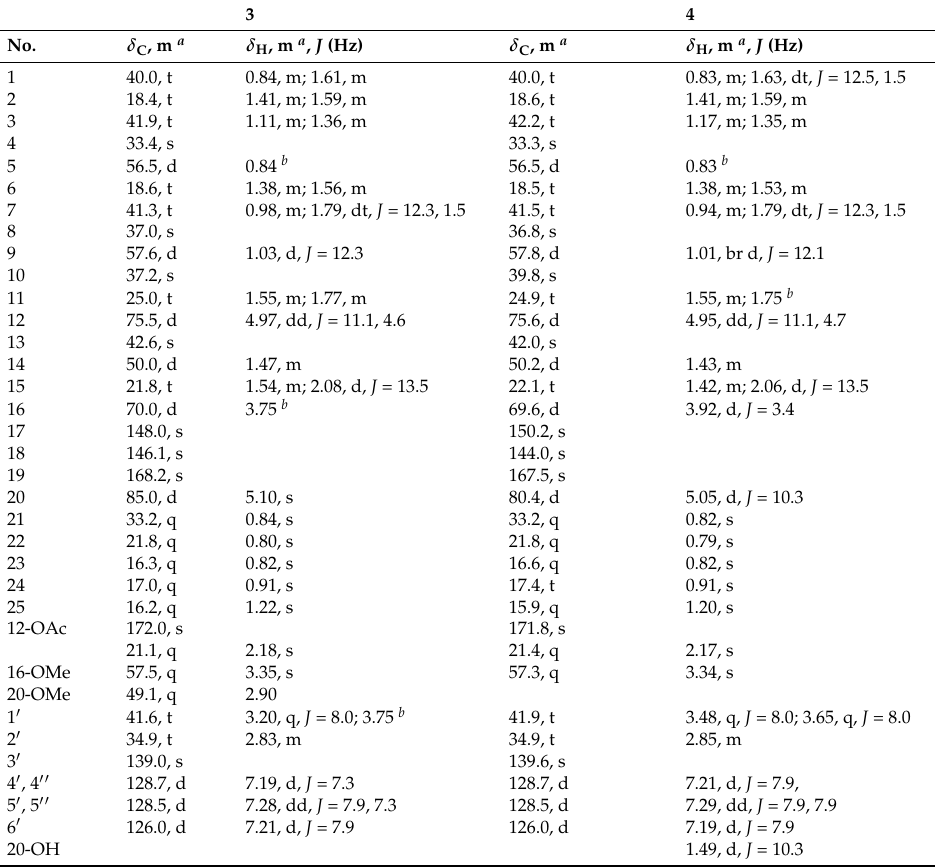
Table 2. 1 H- and 13 C-NMR spectroscopic data of 3 and 4 in CDCl 3 at 600